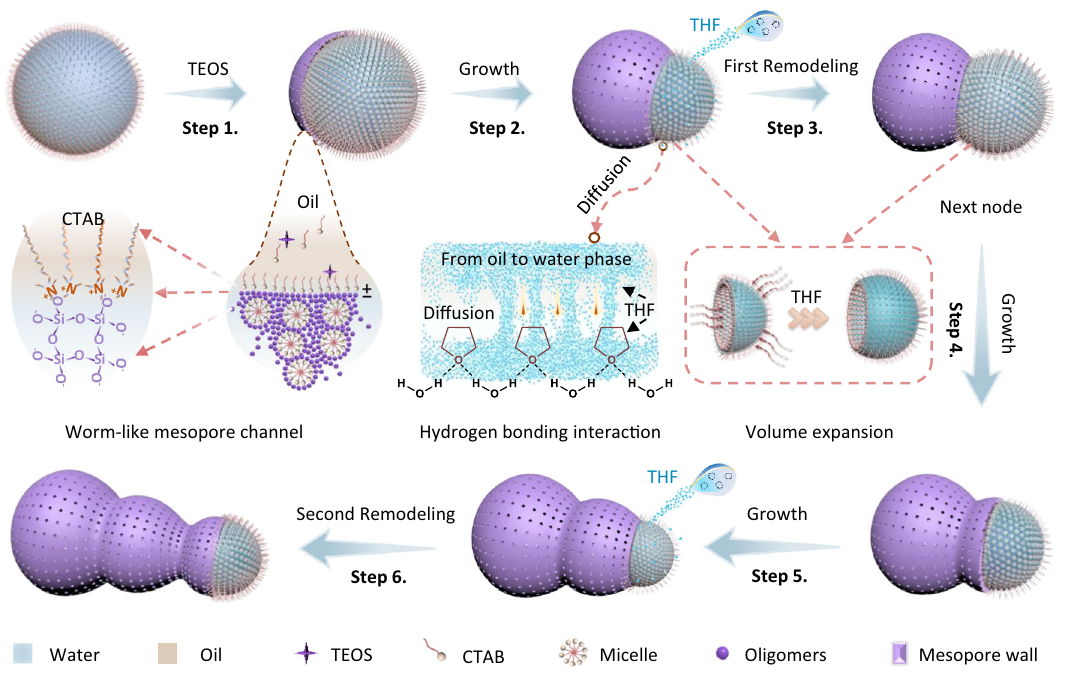
Fig. 7 | The illustration of the nanodroplet remodeling strategy. The formation process of the multi-chambered mesoporous silica nanoparticles. The